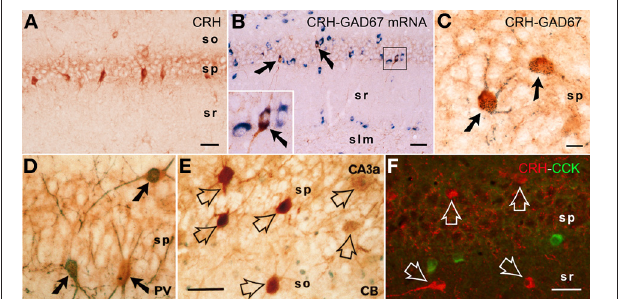
FIGURE 1 | CRH is expressed in interneurons within the hippocampal pyramidal cell layer. (A) CRH-immunoreactive (ir) neuronal somata in the pyramidal cell layer of area CA1. (B,C) All CRH-ir neurons in the pyramidal cell layer in CA1 area are GABAergic interneurons: they co-express the GABA synthesizing enzyme glutamic acid decarboxylase (GAD)-67 at both mRNA and protein levels, using immunocytochemistry coupled with in situ hybridization (GAD67, blue), and dual-labeled immunocytochemistry (CRH, brown; GAD67, black blue), respectively. Arrows indicate the dual-labeled neurons. (D–F) Many CRH-ir neurons in the hippocampus co-express parvalbumin (PV); none co-express calbindin D-28k (CB) or cholecystokinin (CCK). Solid arrows indicate the dual-labeled neurons, and empty arrows denote single-labeled CRH neurons. Abbreviations: so, stratum oriens; sp, stratum pyramidale; sr, stratum radiatum; slm, stratum lacunosum-moleculare. Scale bars = 75 μ m (A,B,F) , 25 μ m (C) , and 50 μ m (D,E) . Reproduced, with permission, from Chen et al. (2004b) (B) and Yan et al. (1998) (D,E) .